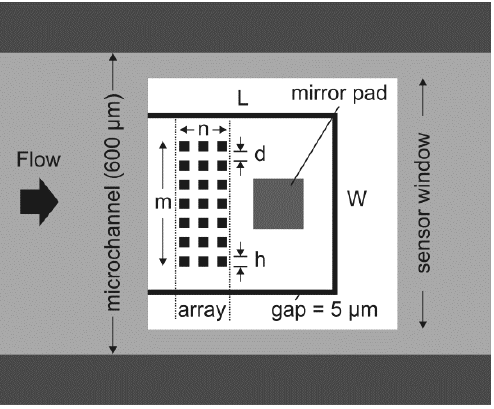
Figure 1. Design parameters for cantilever-based flow sensor integrated in a microfluidic channel; W = cantilever width, L = cantilever length, h = hole size, d = distance between holes, n = columns in array, m = rows in array.